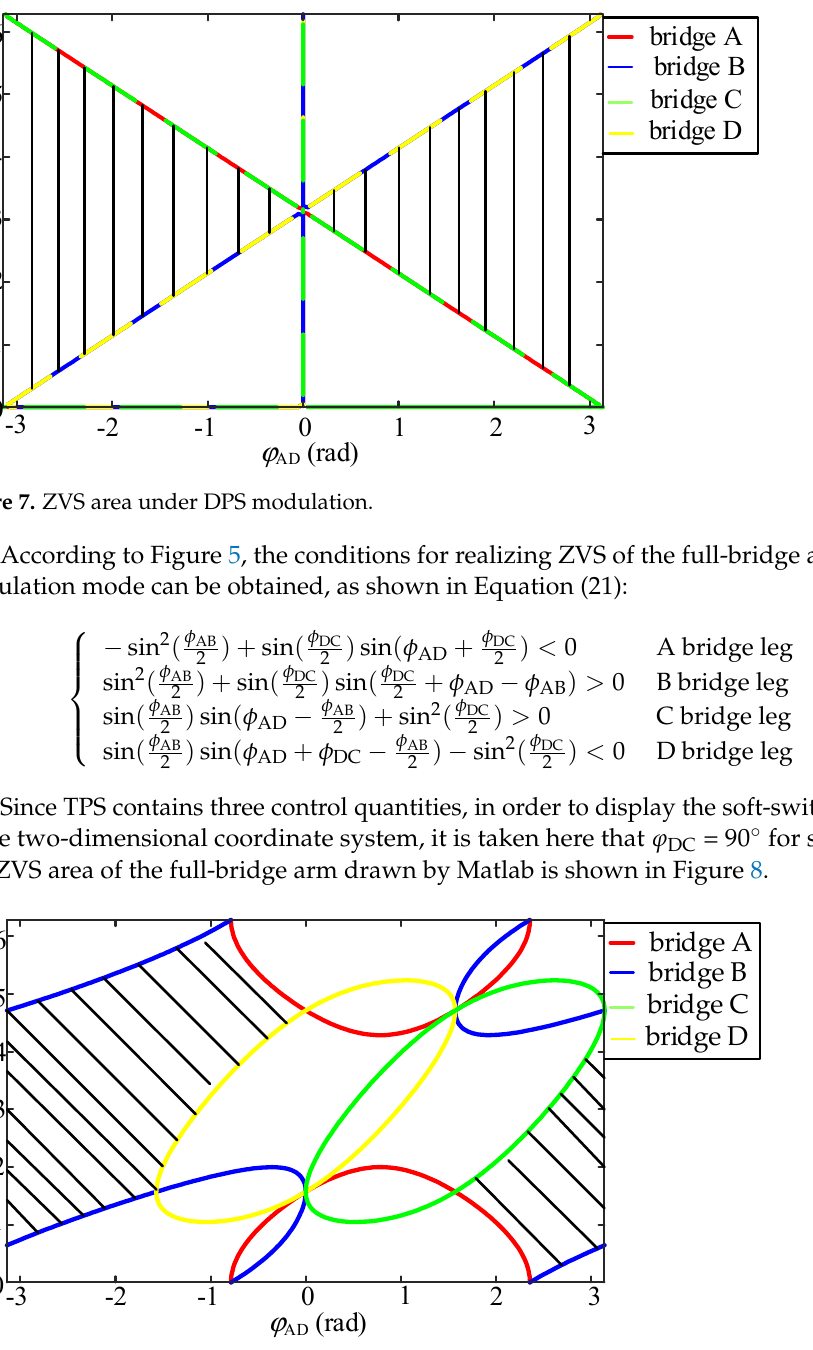
Figure 8. Closeroen arm ZVS area under TPS